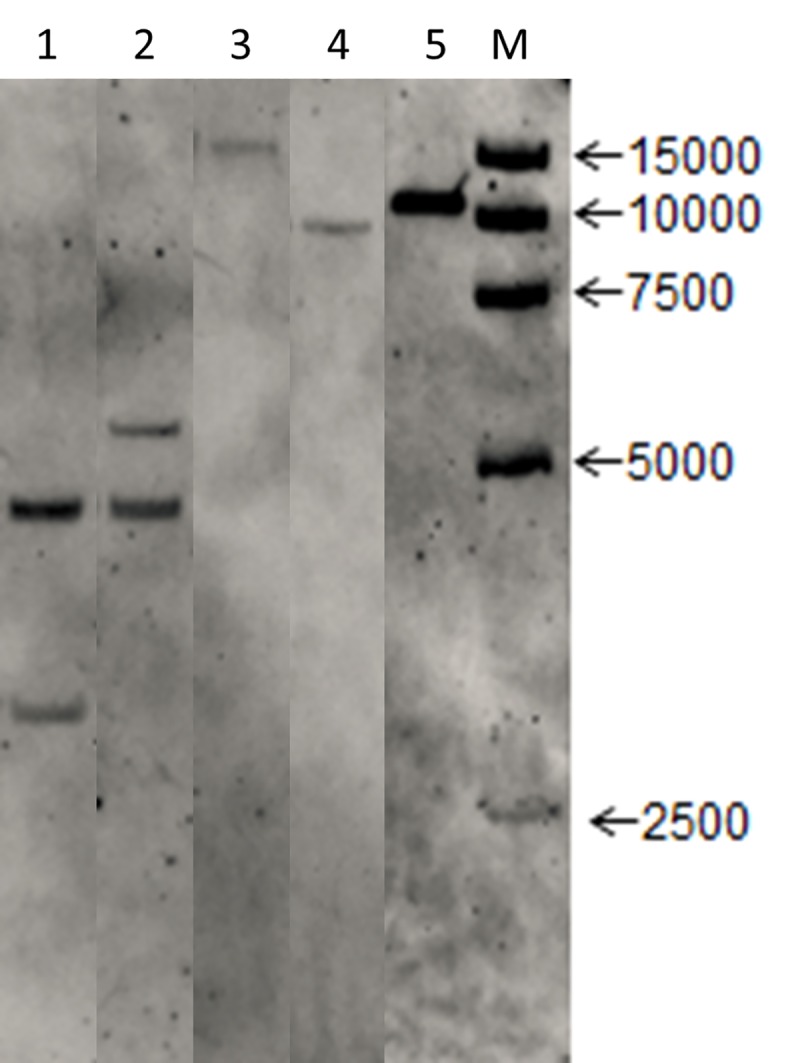
Southern blot analysis of the SbSNAC1-382 line.Lanes 1 to 4, digested DNA of the transgenic line by HindⅢ, EcoRI, BglII and DraI, respectively; lane 5, digested plasmids as positive controls; M, marker.